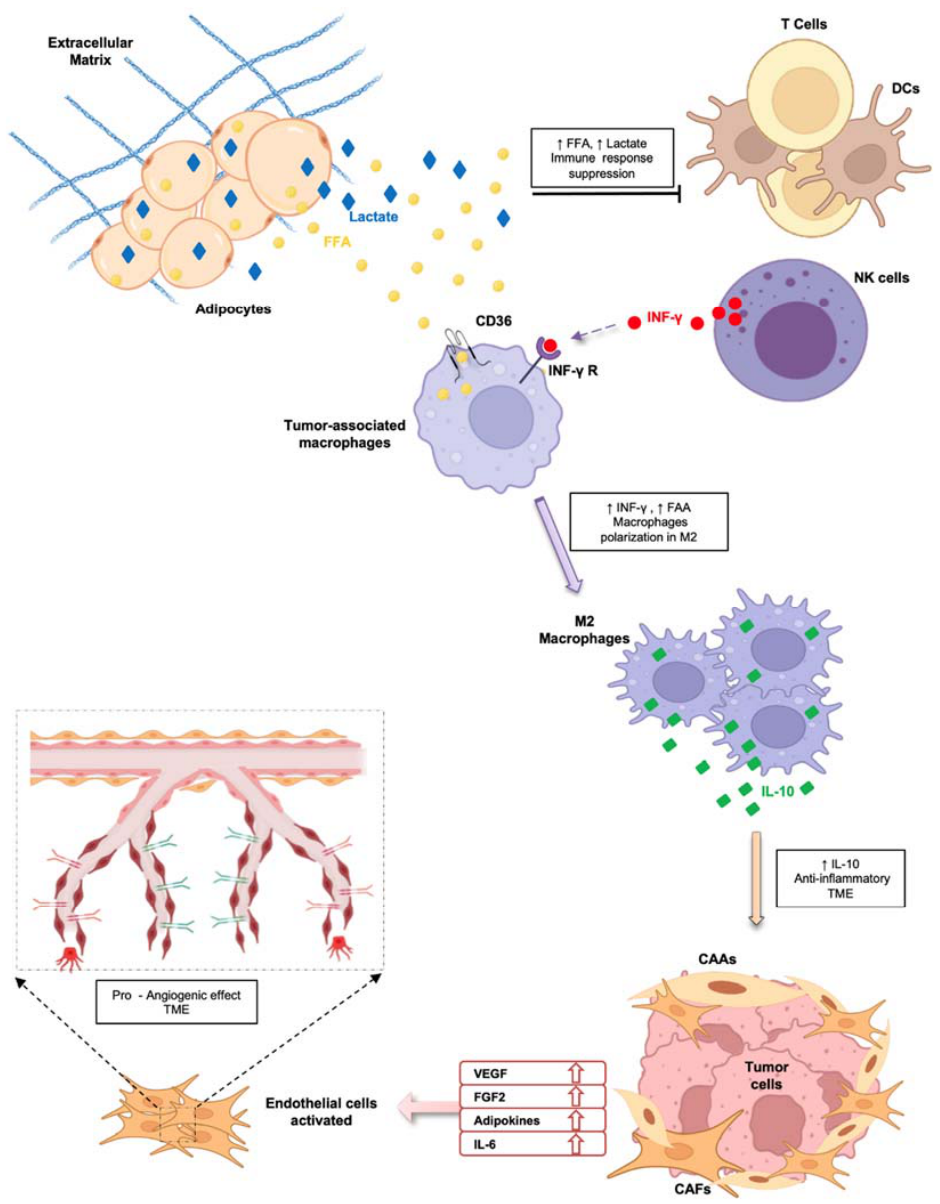
Figure 2. Schematic representation of indirect effects mediated by adipocytes and cancer ‐ associated adipocytes on immune system cells, tumor cells, and endothelial cells, leading to cancer progression. ECs in healthy tissue are usually quiescent and await activating inputs. The secretory ‐ modulator factors present in TME stimulate reactivation of ECs, promoting their proliferation and migration, reducing the expression of critical fate markers, and inducing the acquisition of adhesion molecules that are attractive for leukocytes [121]. Consequently, tumor ‐ associated ECs dramatically affect all stages of disease. The formation of new vessels, called tumor neo ‐ angiogenesis, plays an important role in both the growth of the primary tumor and the metastatic dissemination of cancer cells [122]. Many of the key factors responsible for the activation of ECs are produced by CAAs and CAFs. CAAs, through the release of large amounts of vascular endothelial growth factor (VEGF), fibroblast growth factor ‐ 2 (FGF2), and adipokines, such as leptin, adiponectin, resistin, and IL ‐ 6, in TME induce a pro ‐ angiogenic microenvironment that is responsible